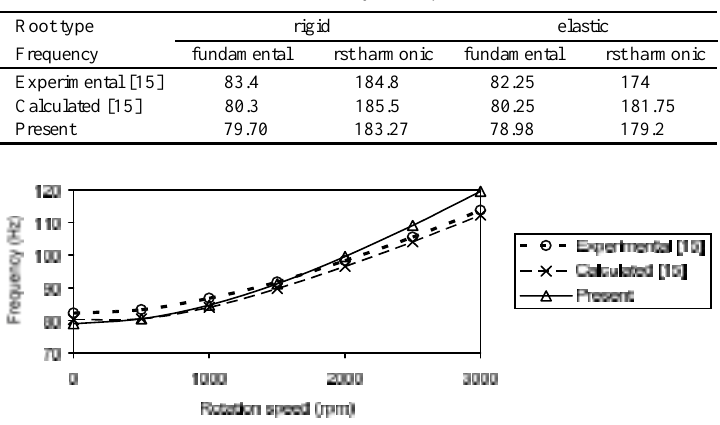
Fig. 4. Fundamental frequencies of blade in terms of the rotation speed.